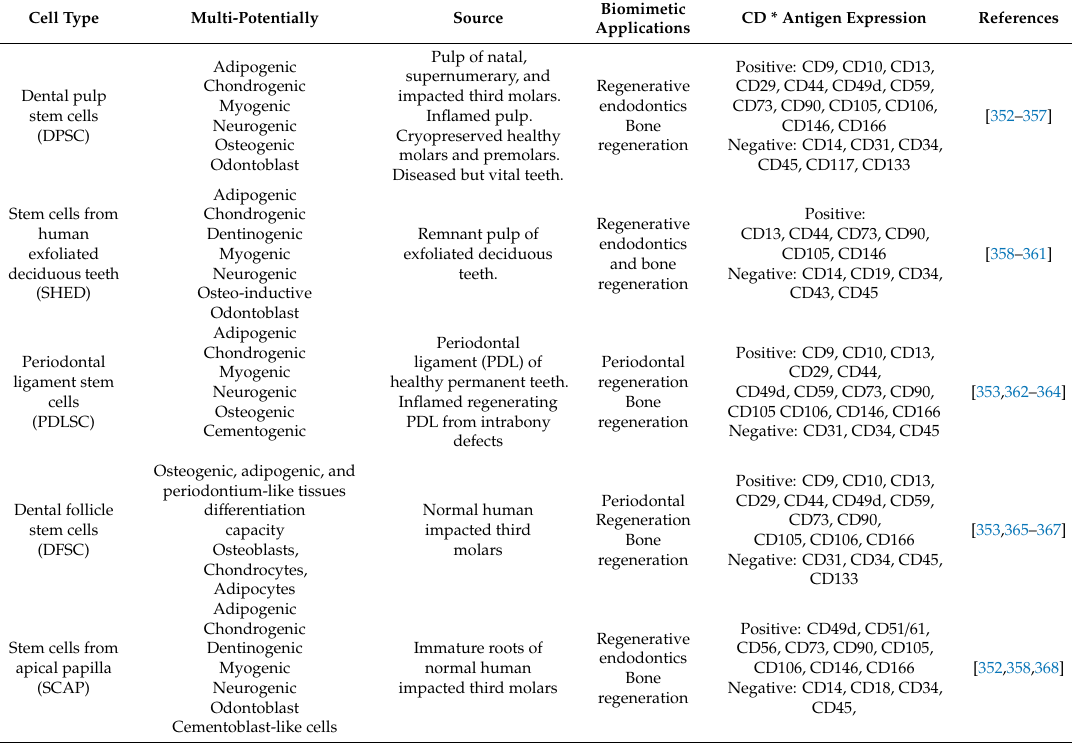
Table 8. Summary of human-derived dental tissues mesenchymal stromal cells (MSCs): isolation, multi-potentially, source, and cd antigen expression and their clinical application in biomimetic tissue